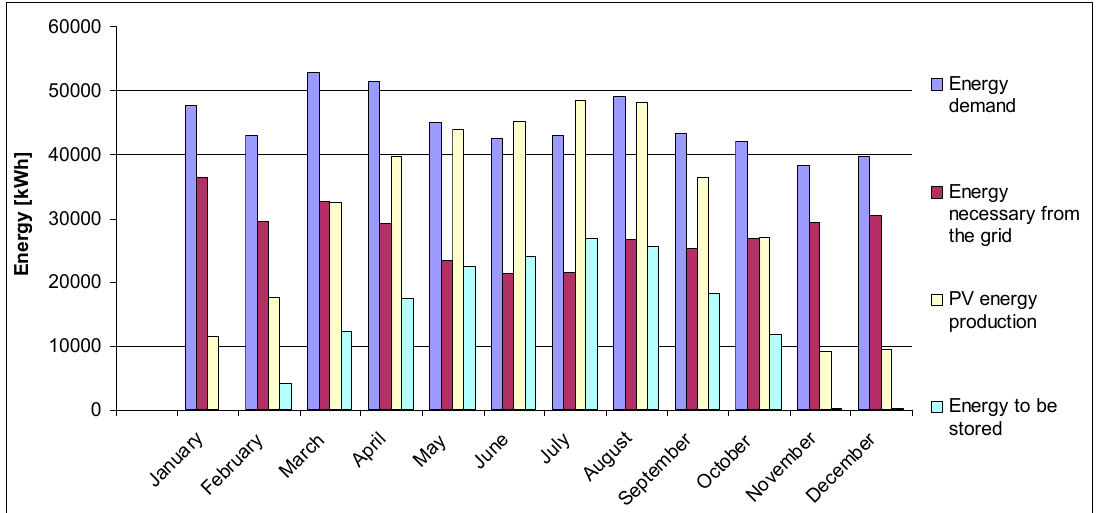
Figure 7. Monthly energy demand, energy production by PV system, energy necessary from the grid, and energy necessary to be stored in batteries. Table 3. Year energy